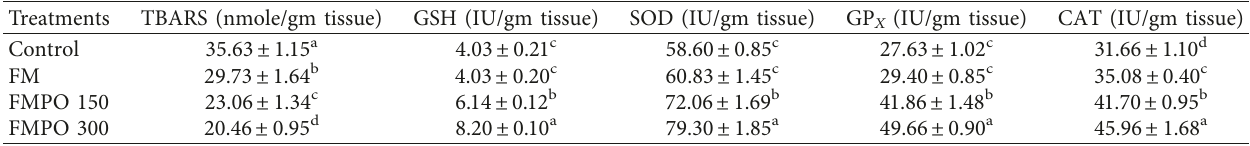
Table 8: Antioxidant biomarkers of rats fed with and without functional fermented beverages.